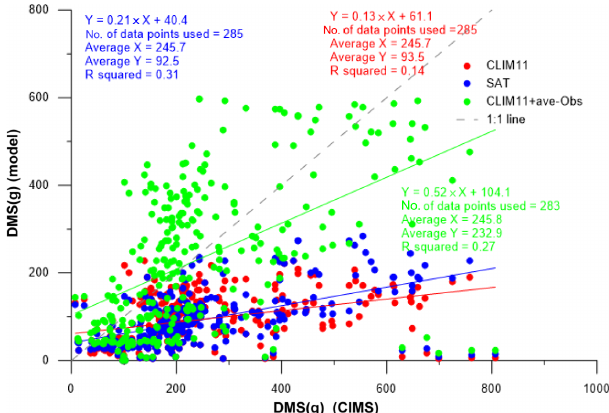
Figure 10. The comparison of DMS(g) measured by CIMS onboard the Amundsen (July–August 2014) with GEM-MACH simulations, using CLIM11 (red), SAT (blue) and CLIM11 + ave-Obs (green). The linear regression method is used to obtain the correlation be- tween observation and model results. The dashed line is the one-to- one